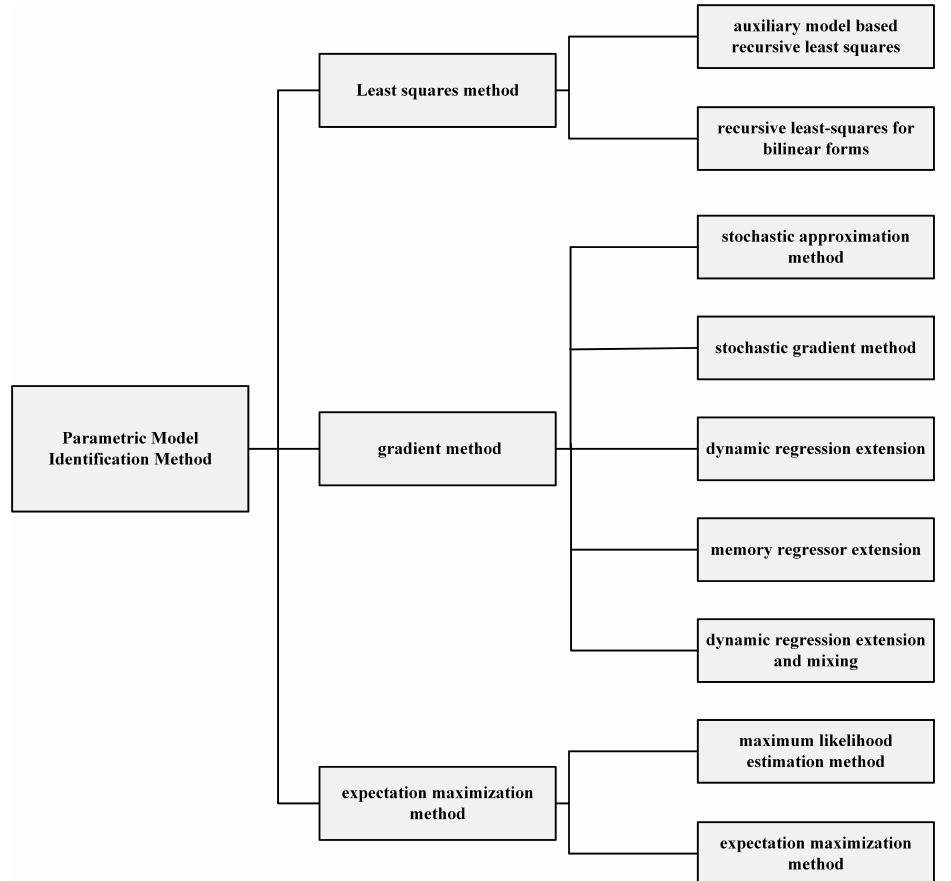
Figure 2. Overview of Parametric Model Identification